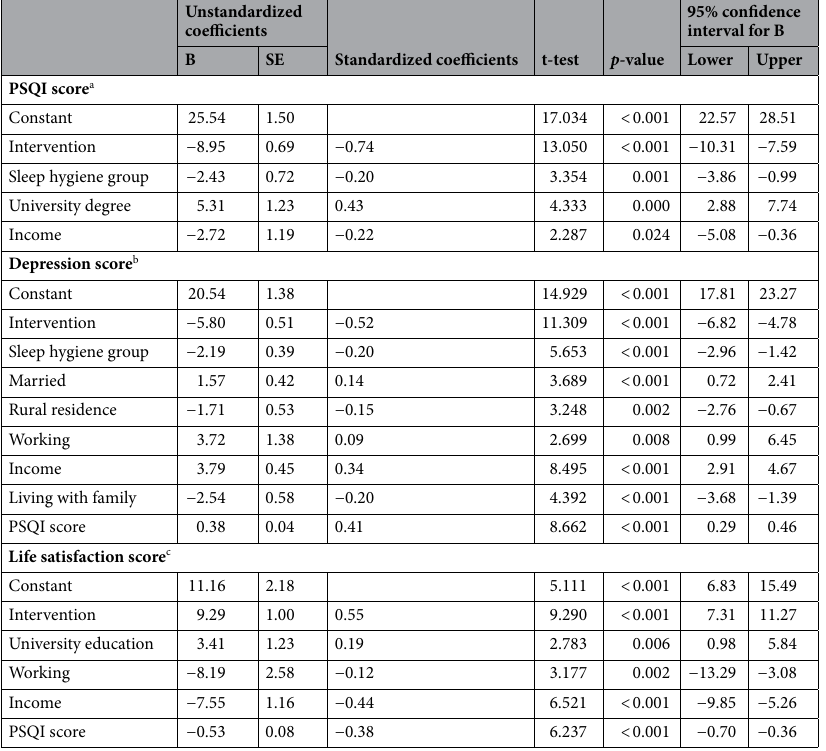
Table 6. Best fitting multiple linear regression model for the PSQI, depression, and life satisfaction scores. a R-square = 0.63, Model ANOVA: F = 49.64, p < 0.001. Variables entered and excluded: age, gender, marital status, residence, job status, living alone. b R-square = 0.89, Model ANOVA: F = 123.55, p < 0.001. Variables entered and excluded: age, gender, education, residence. c R-square = 0.83, Model ANOVA: F = 114.04, p < 0.001. Variables entered and excluded: age, gender, marital status, residence, living alone, depression score,